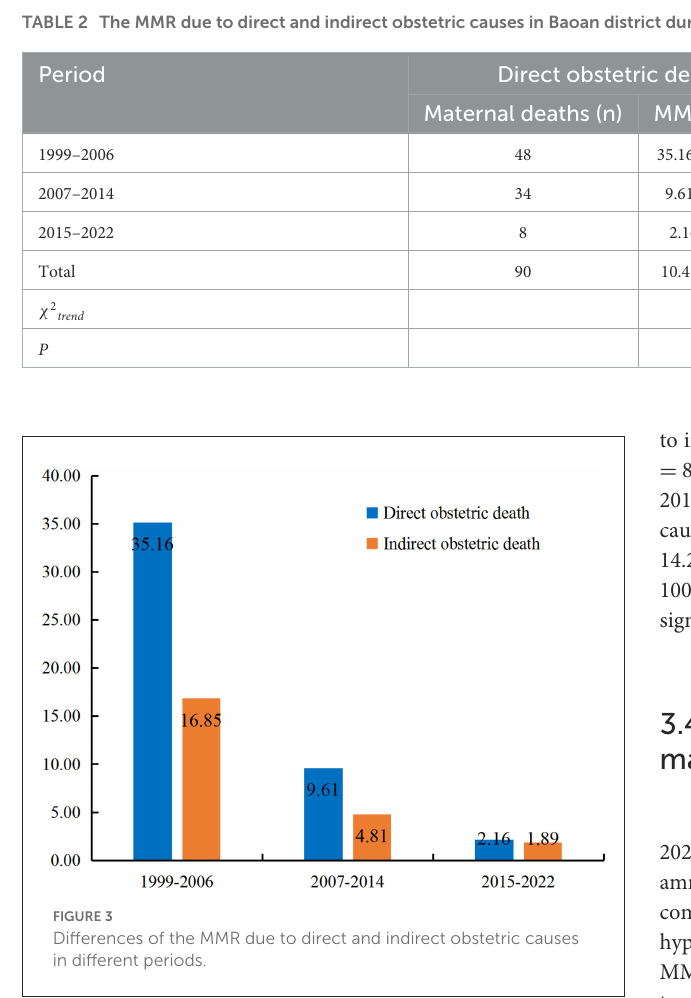
respectively. Both groups shown significant decrease in MMR when analyzed the trend among different research periods (Table